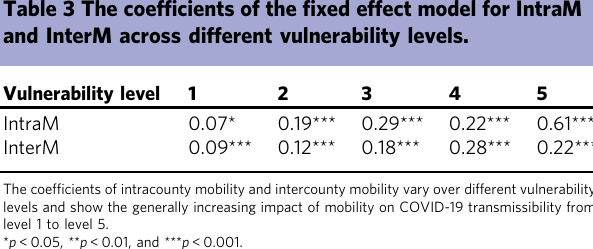
Table 4 The effect of a 25% change in intracounty mobility (IntraM) and intercounty mobility (InterM) on the change in the R t in percentage form